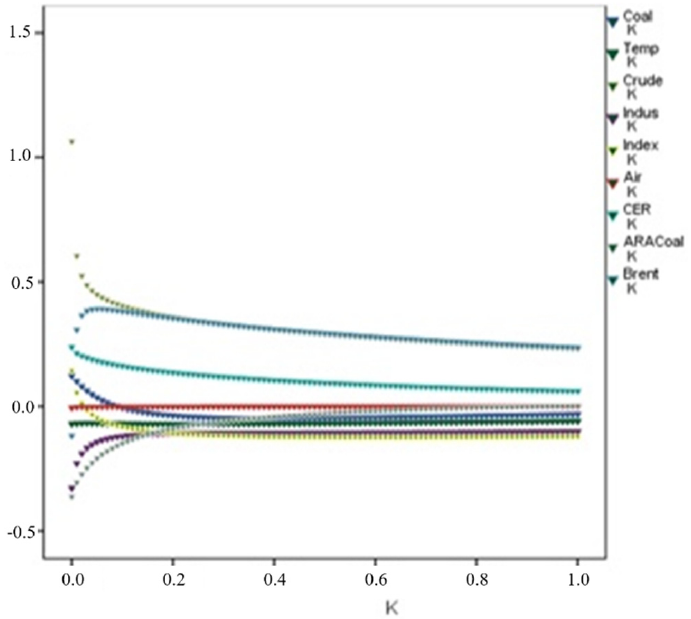
Figure 3. Ridge regression results.